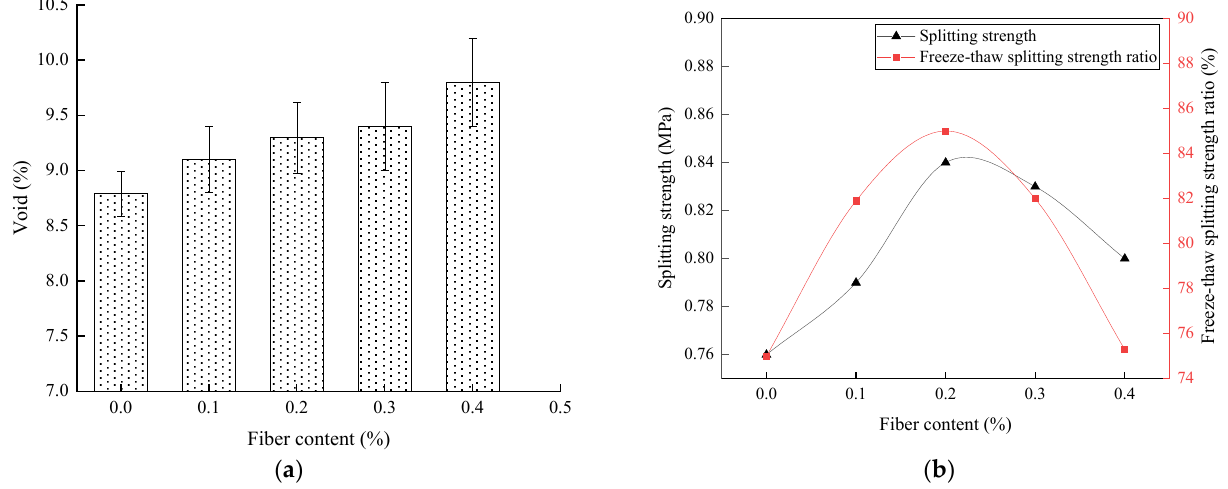
Figure 3. The effect of fiber content on the performance of CRAM: ( a ) void; ( b ) splitting strength and freeze–thaw splitting strength ratio.